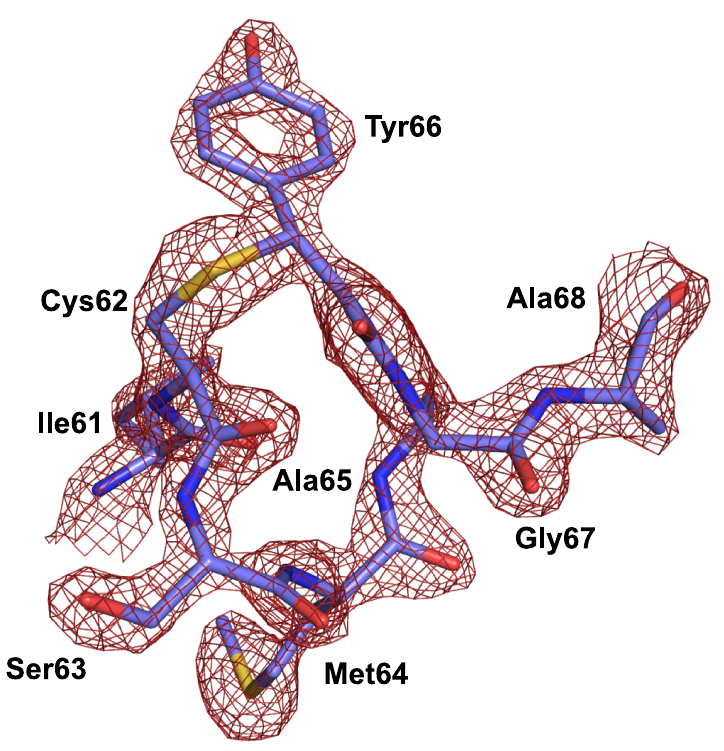
Fig 6. 2 F obs − F calc electron-density map contoured at a 2.0 σ level superimposed over the model of the chromophore and the 3 covalently bonded residues in the structure of AausFP2. The data underlying this figure may be found in PDB